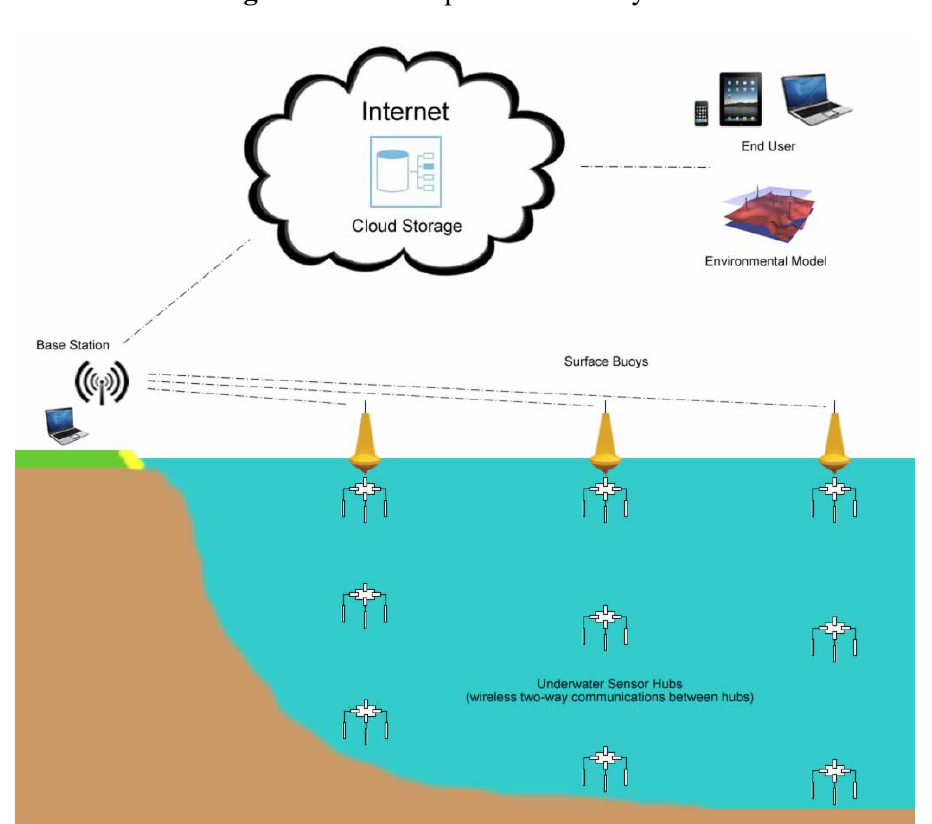
Figure 1. The complete SEMAT